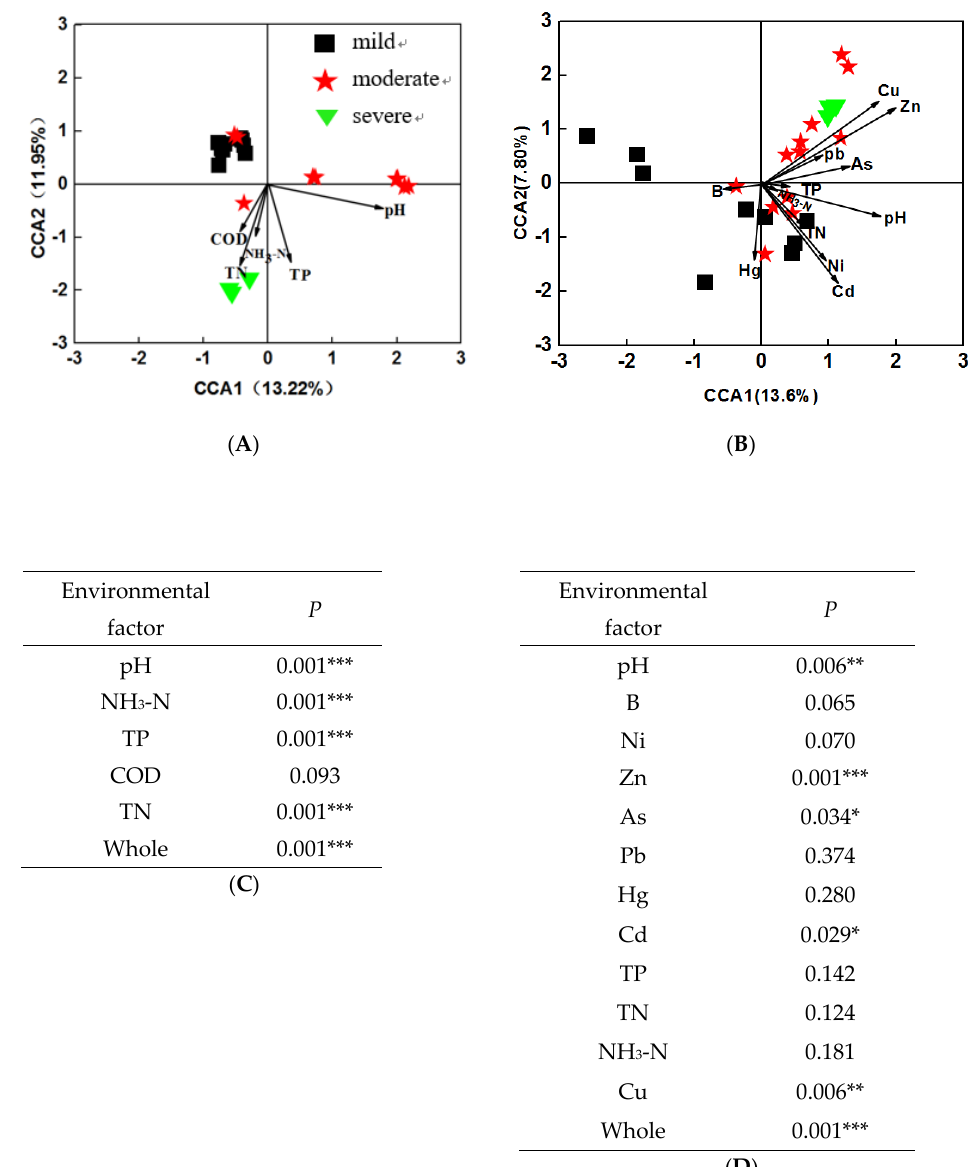
Figure 5. Canonical correspondence analysis (CCA) plot of bacterial communities and environmental parameters in water samples ( A ), and sediment samples ( B ). Model significance of water samples ( C ) and sediment samples ( D ).